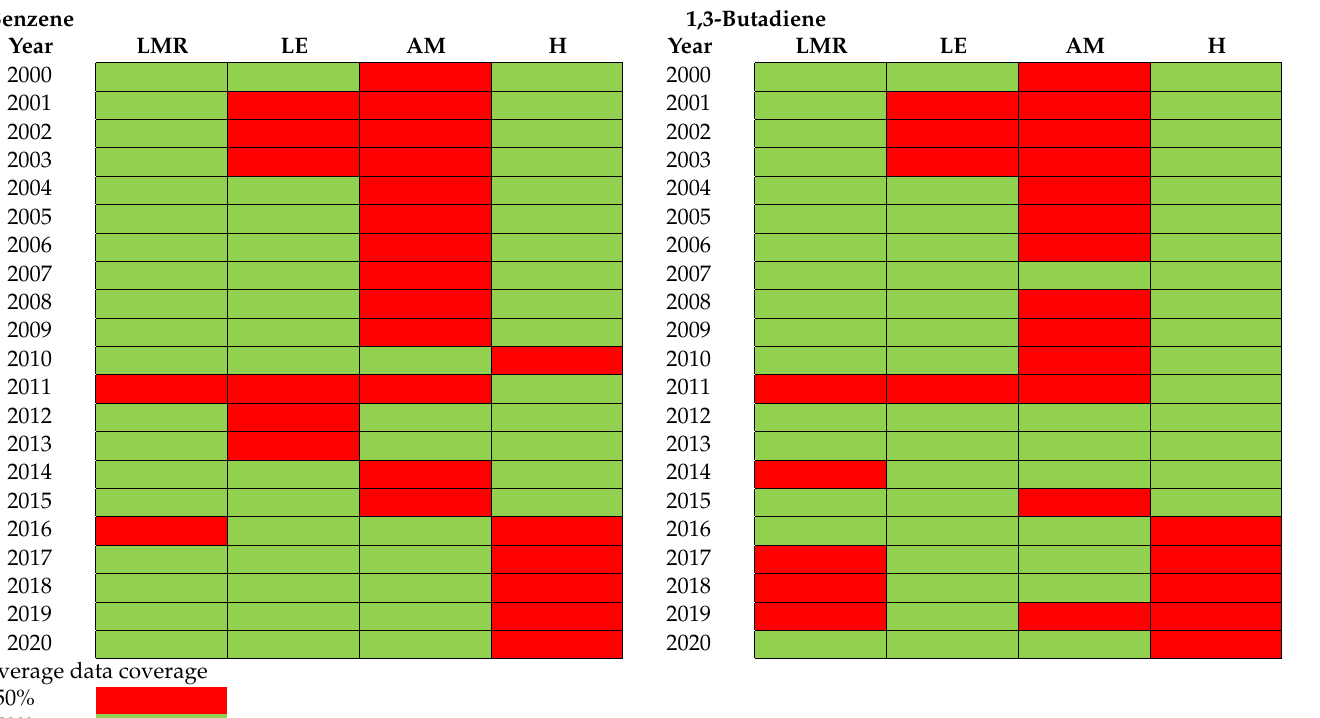
Table A1. Representation of data availability for this study. Years where data coverage was less than 50% (red) have been removed to avoid seasonal